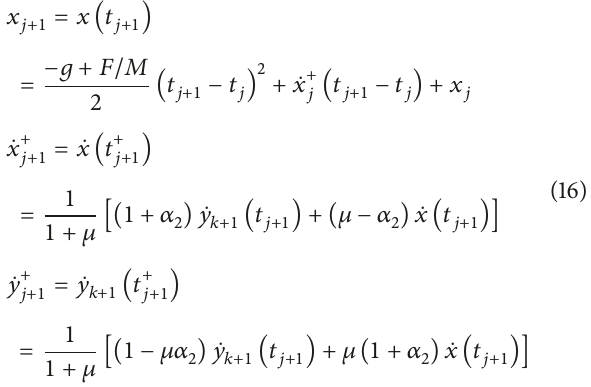
Figure 7: The motion of the impact block and drill